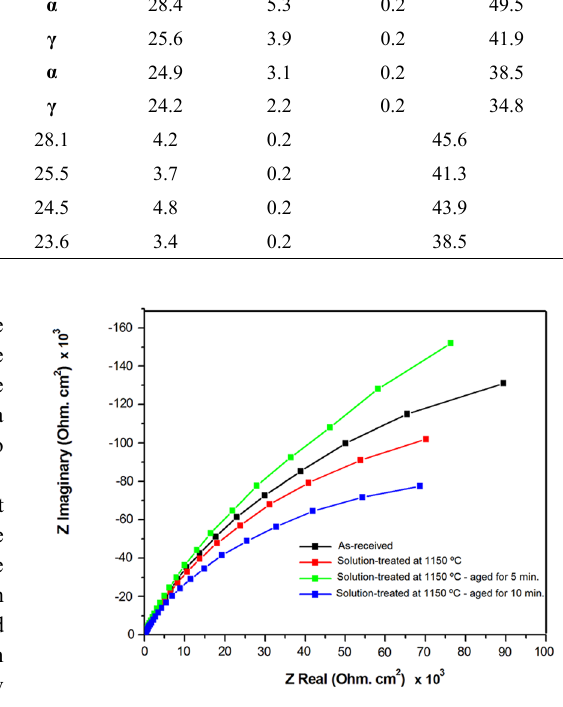
Figure 4. Nyquist Diagram of UNS S32520 super duplex stainless steel in the conditions: as-received, solution-treated at 1150ºC, solution treated at 1150ºC and aged at 850ºC for 5 and 10 min. in 3.5% NaCl solution at room temperature